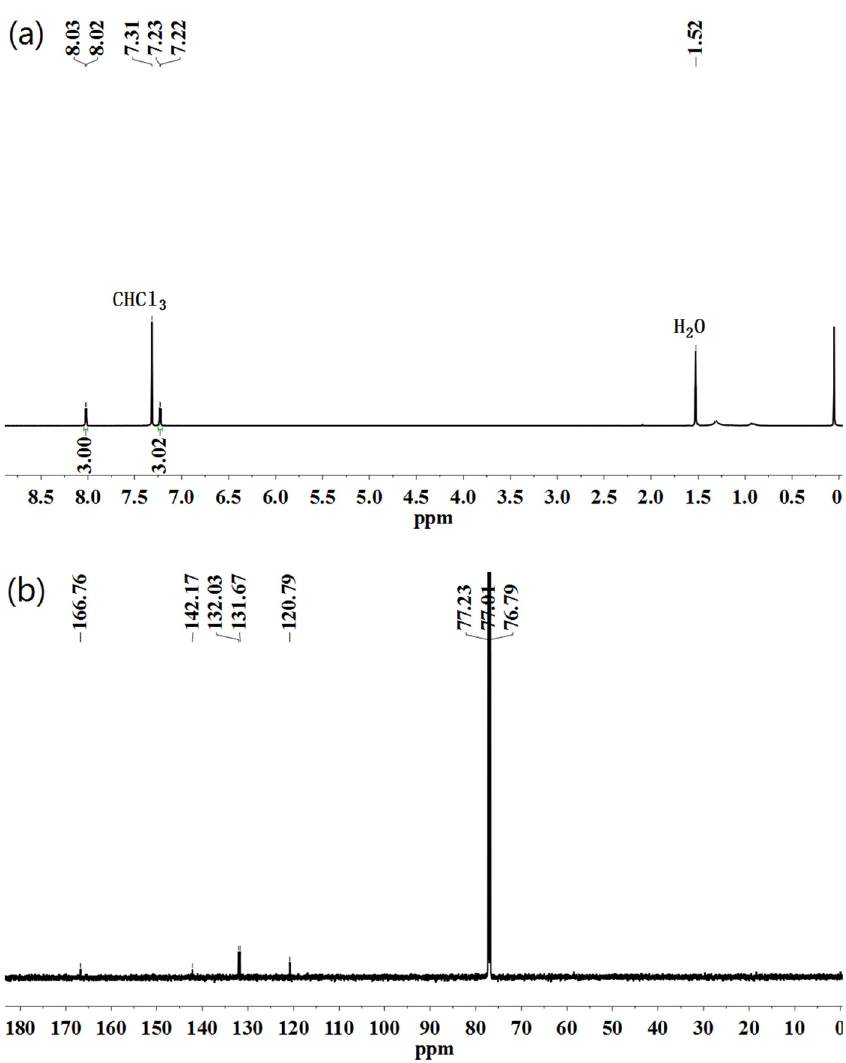
Figure A1: ( a ) 1 H NMR and ( b ) 13 C NMR spectra of TBrTh in CDCl 3 . 1 H NMR ( δ , ppm ) : 8.03 ( d, J = 4.0 Hz, 3H ) and 7.23 ( d, J = 4.0 Hz, 3H ) . 13 C NMR ( δ , ppm ) : 166.76, 142.17, 132.03, 131.67, and